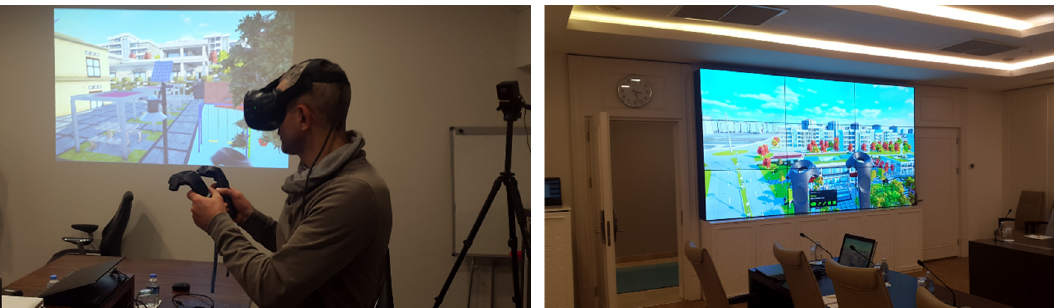
Figure 22. Virtual reality exploration of the LoD3 future city model using the Unity Game Engine environment.